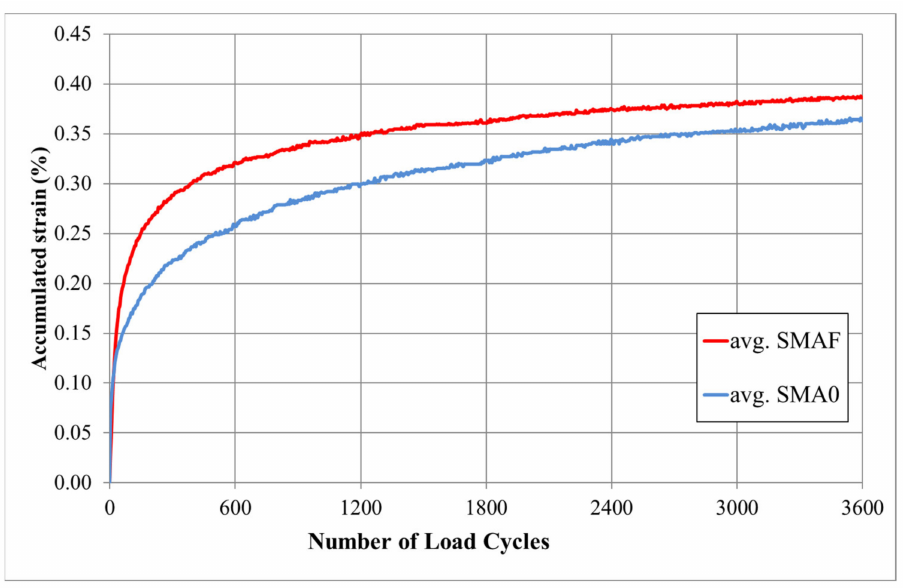
Figure 5. RLAT average results at 40 ◦